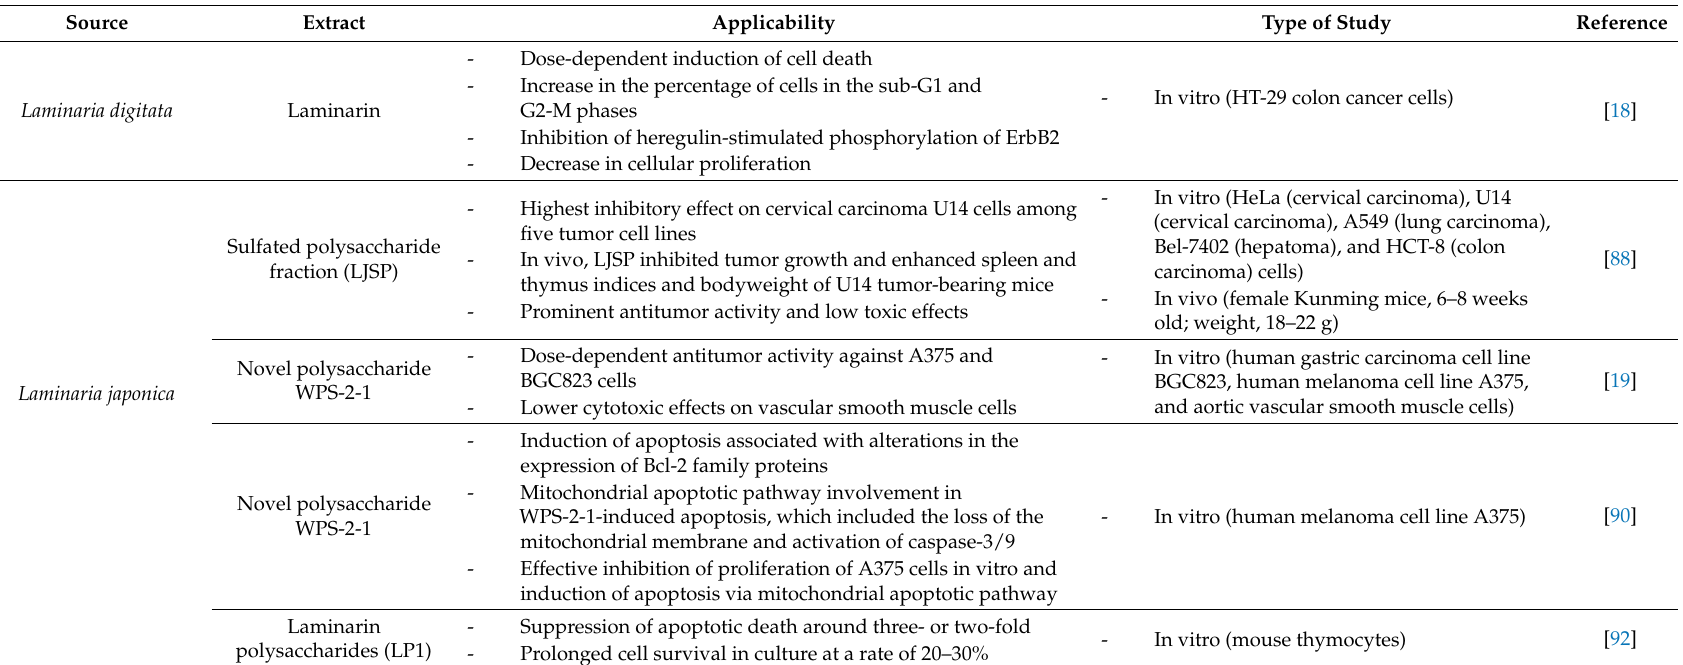
Table 2. Antitumor activity of β -glucans from seaweed of the genus Laminaria